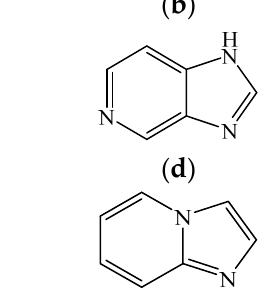
Figure 1. Isomer forms of imidazopyridines. ( a ) imidazo[4,5- b ]pyridine; ( b ) imidazo[4,5- c ]pyridine; ( c ) imidazo[1,5- a ]pyridine; ( d ) imidazo[1,2- a ]pyridine.